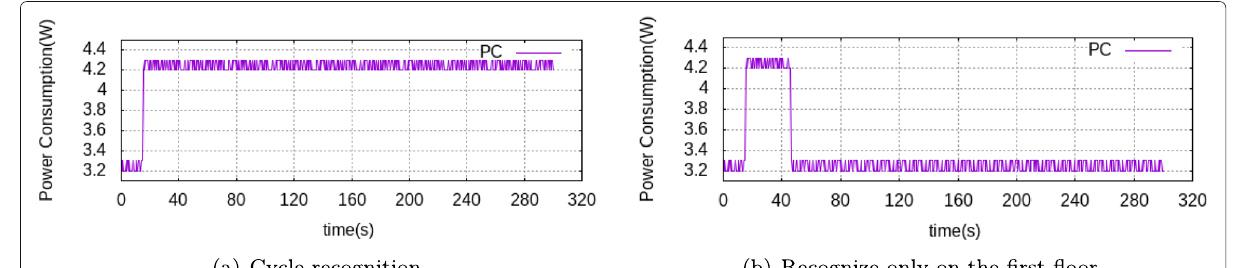
Fig. 12 Comparison of different recognition modes